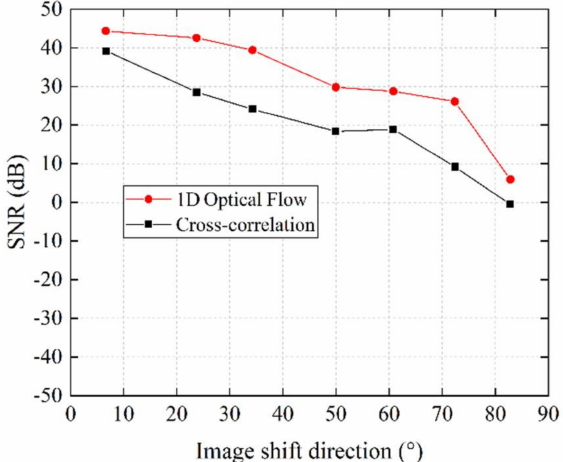
Figure 15. Dependence of the SNR of the restored audio signal on the 2D image shift angle for different algorithms.